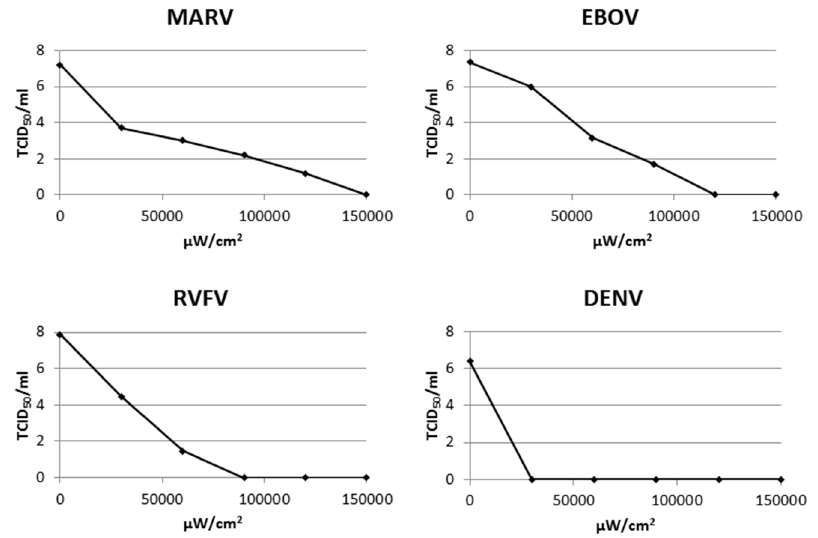
Figure 1. Dose ‐ dependent inactivation of multiple viruses by UV ‐ A in the presence of Figure 1. Dose-dependent inactivation of multiple viruses by UV-A in the presence of 4 ′‐ aminomethyl ‐ trioxsalen (AMT). 4 1 -aminomethyl-trioxsalen